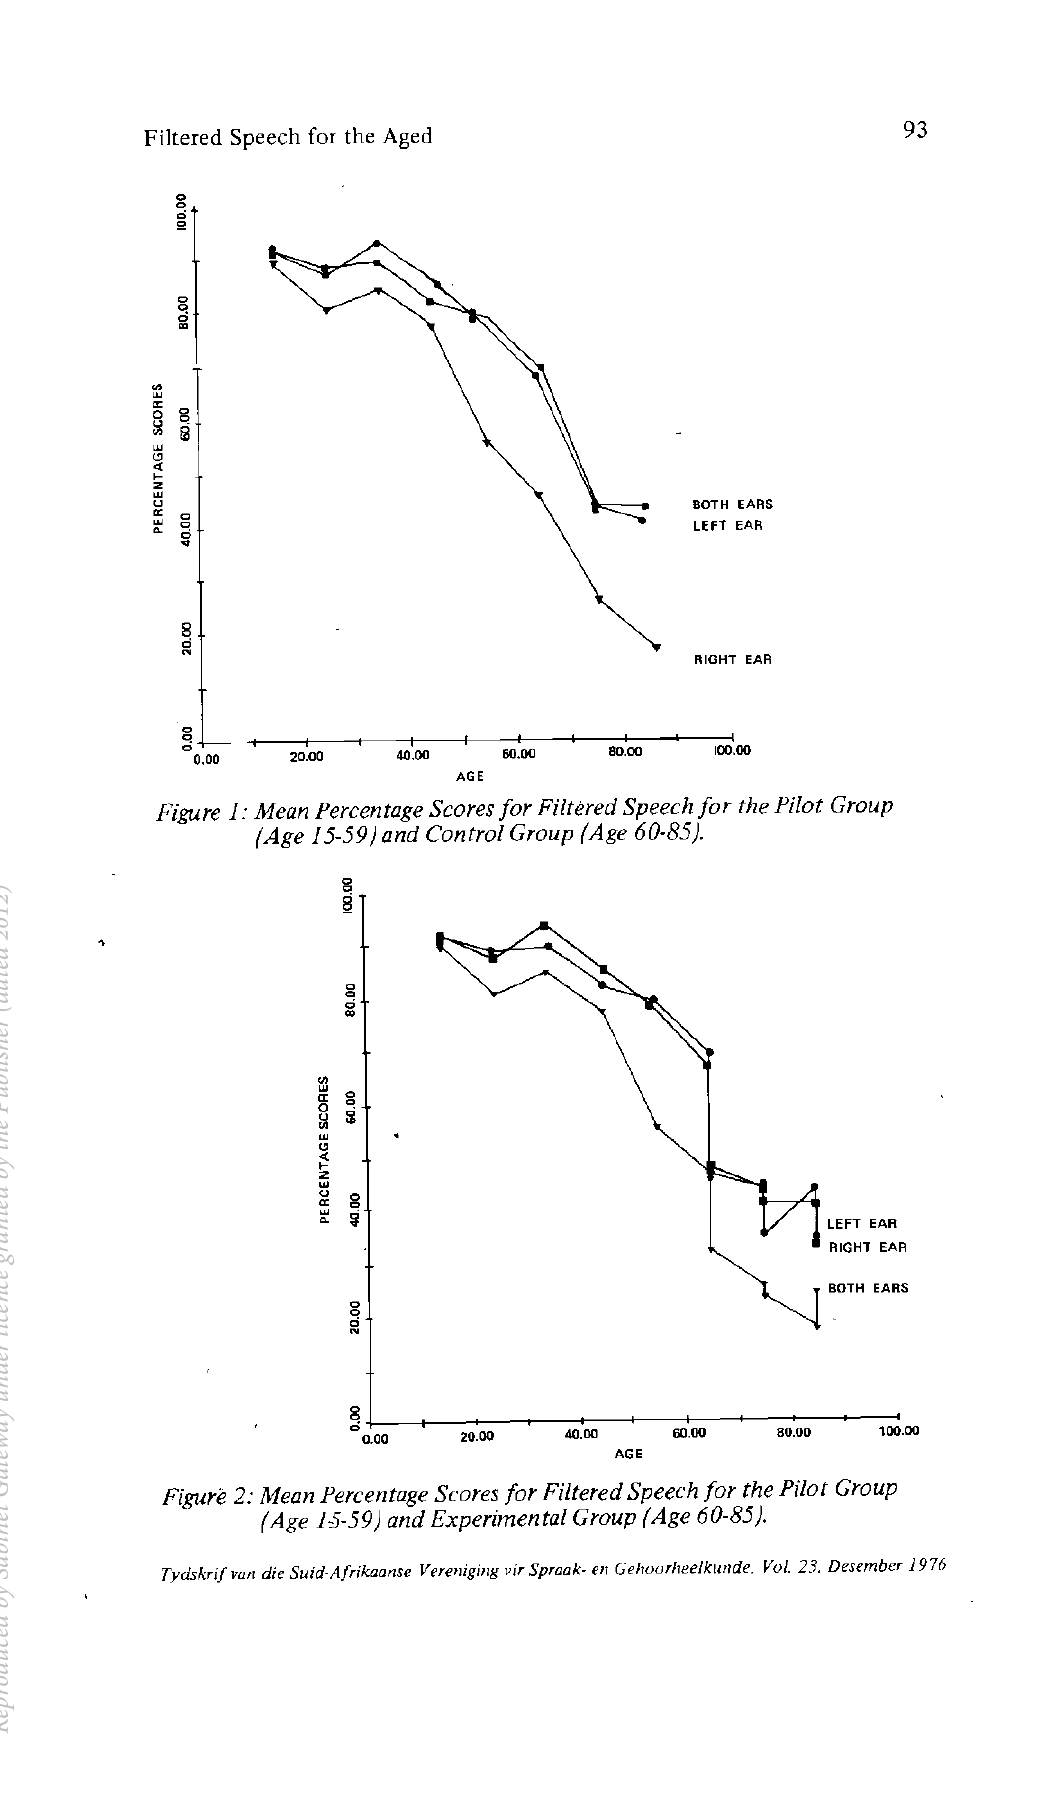
Figure 2: Mean Percentage Scores for Filtered Speech for the Pilot Group (Age 15-59) and Experimental Group (Age 60-85). Tydskrif van die Suid-Afrikaanse Vereniging vir Spraak-en Gehoorheelkunde Vol. 23 Desember